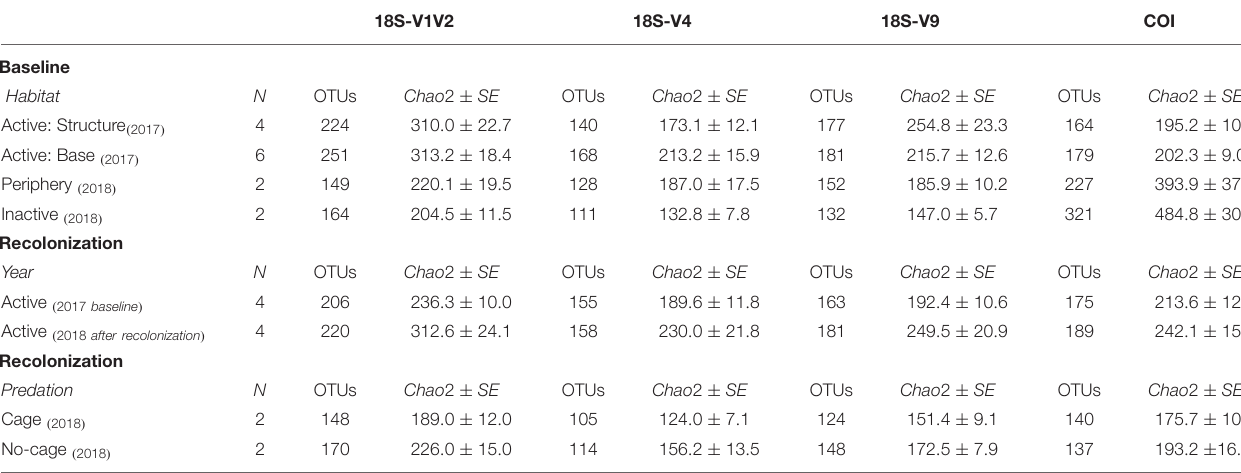
TABLE 3 | Metazoan species richness values of baseline and recolonization data for the four eDNA